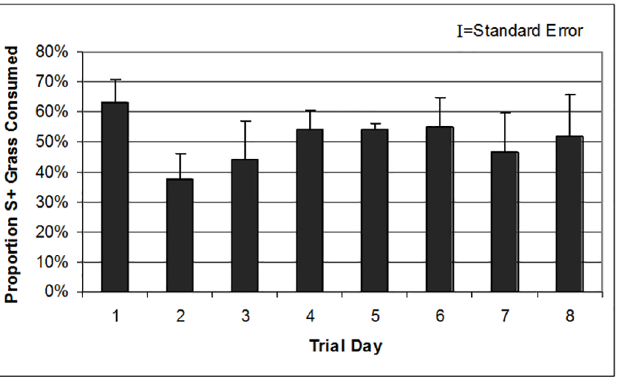
Fig 4. No preference for plants infected with S . fimicola CID 323 was exhibited by sheep. Mean daily consumption of Sordaria -inoculated (S+) B . tectorum expressed as the percentage of total consumed when six sheep were presented with equal amounts of S+ and S- (uninoculated, control)